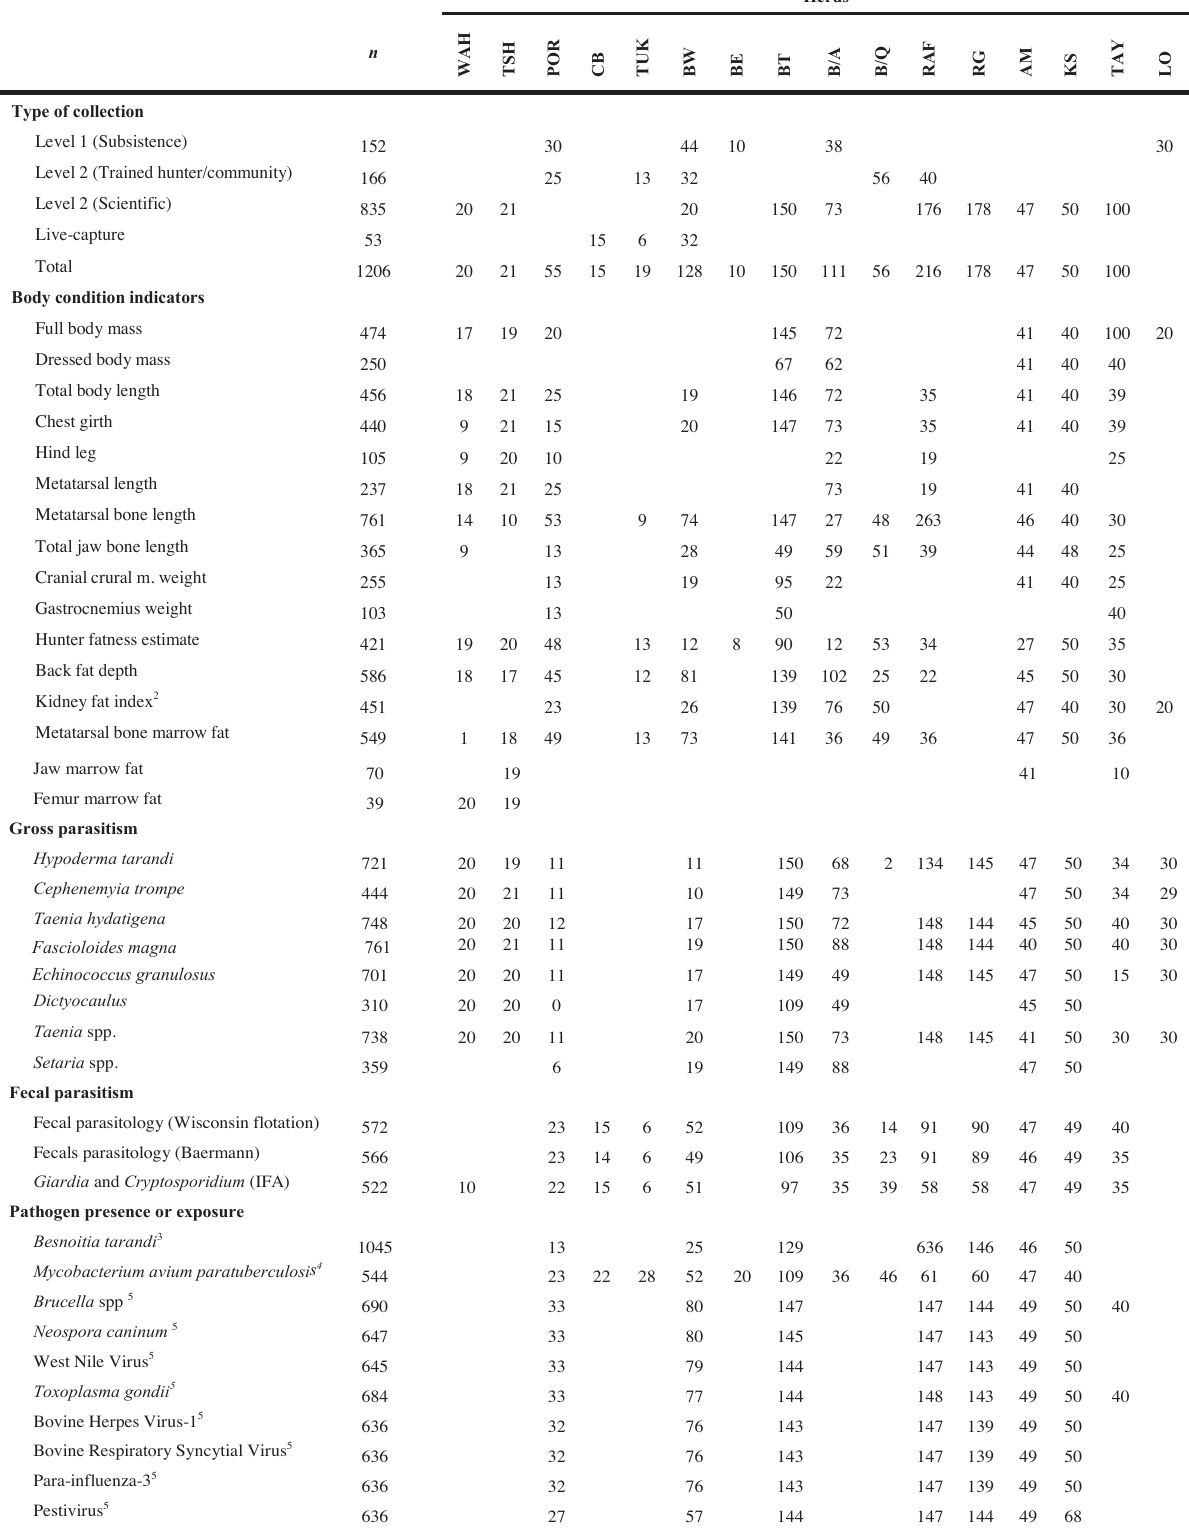
Table 2. Collections done by the CARMA network during International Polar Year activities, 2007 – 2010. The types of collections, data, samples, and the number of animals from each herd that were sampled (n) are indicated. Blank cells indicate that no animals were